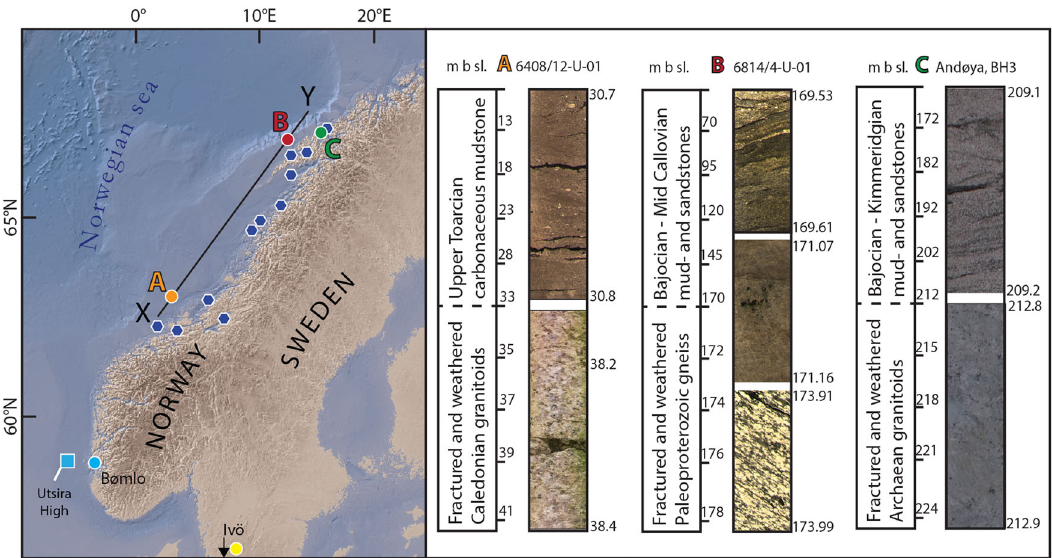
Fig. 2 Study area and site locations on- and offshore Norway. (Left) Map with studied wells 6408/12-U-01 ( A ), 6814/4-U-01 ( B ), and Andøya Borehole BH3 ( C ). The light blue square and circle indicate the location of the Late Triassic saprolite dated in Well 16/3-4 (Utsira High) and on the island of Bømlo 20 , respectively. Yellow circle marks the Ivö location in southern Sweden 20 . Blue hexagons: Location of Jurassic basins 98 . Pro fi le X-Y is schematically illustrated in Fig. 4a. (Right) Log, stratigraphy, and selected core images of wells 6408/12-U-01, 6814/4-U-01, and Andøya BH3 (mbsl. meter below sea fl